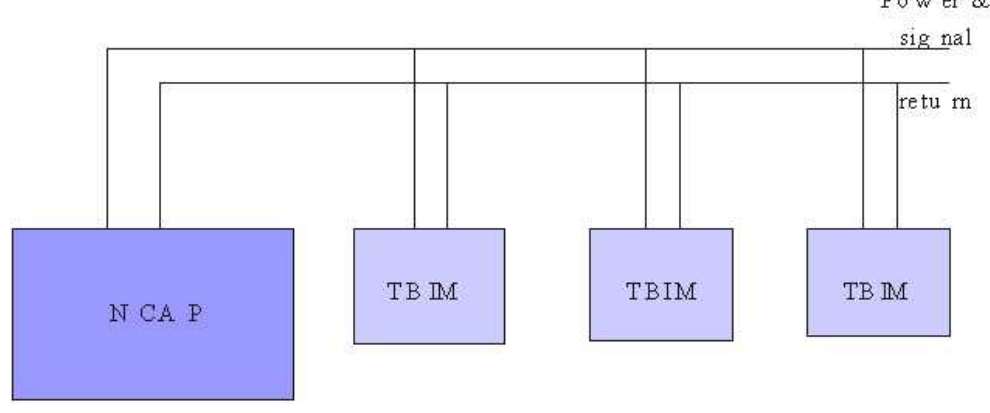
Figure 4 . Physical representation of